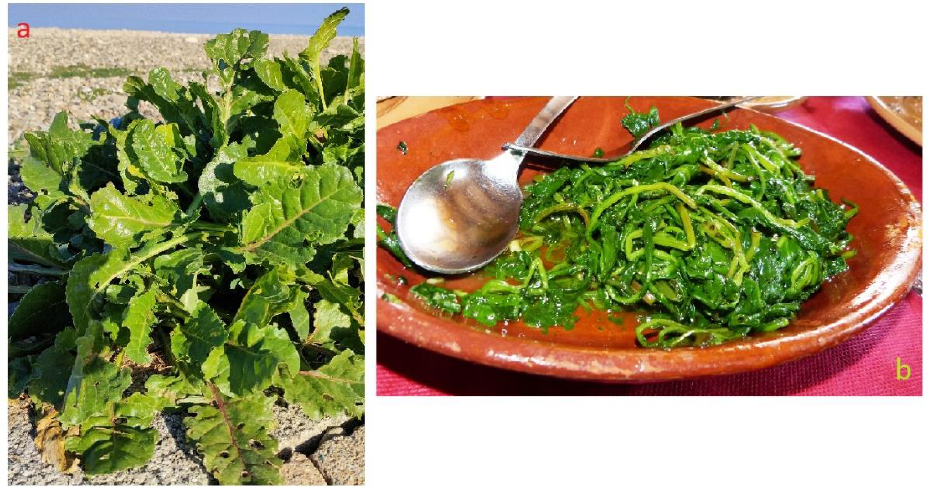
Figure 14. Beta vulgaris subsp. maritima ( a ); a typical side dish with sea beet ( b ).